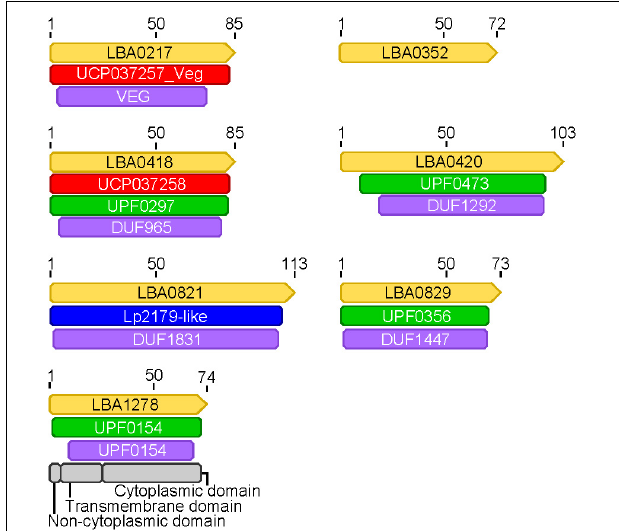
FIGURE 8 | Protein domains in hypothetical core transcriptome genes. Protein domains were annotated in genes (yellow) found to be part of the core transcriptome that had hypothetical annotations. The naming convention from L. acidophilus is used for each gene (LBA####). Domains from different databases are colored as follows: red, green, purple, blue, gray.